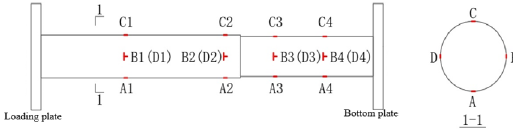
Fig. 9 Arrangement of strain